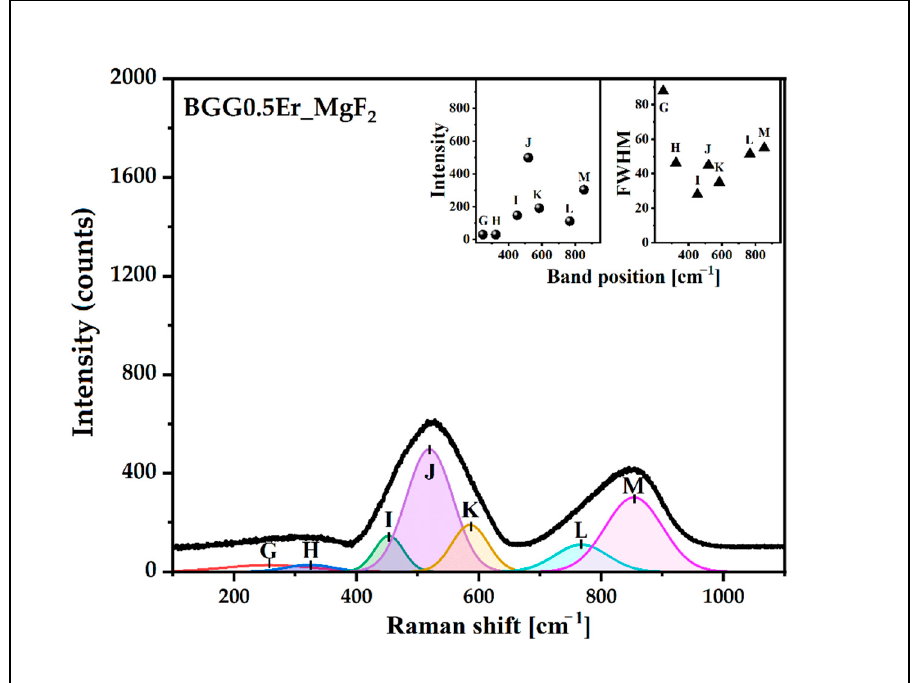
Figure 13. Deconvoluted Raman spectrum of BGG0.5Er_MgF 2 glass.